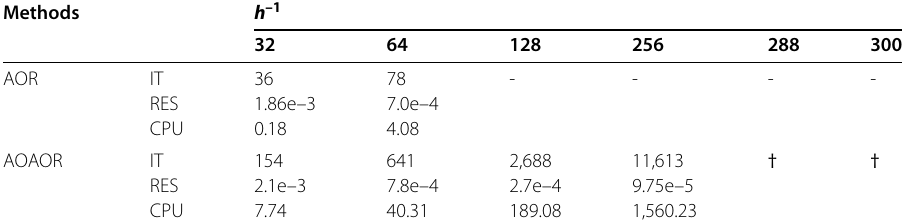
Table 3 Numerical results when ξ = ζ = 0, σ = 2.5 ( ε = h 2 /5) Methods